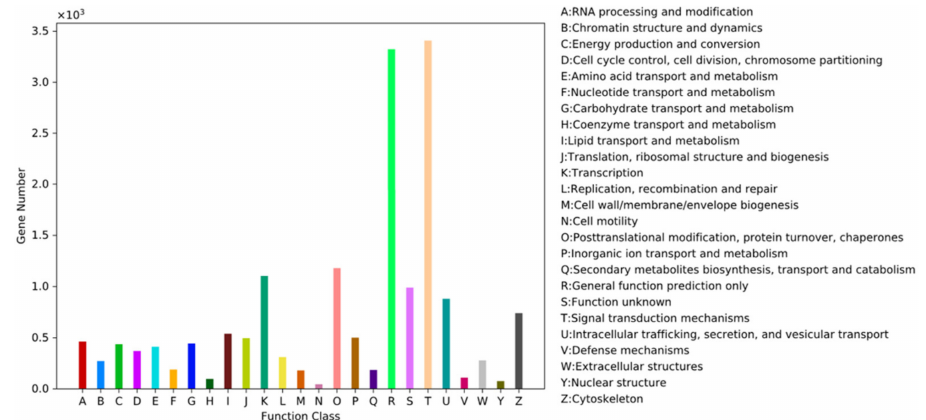
Figure 2. KOG chart of Functioned gene dives.